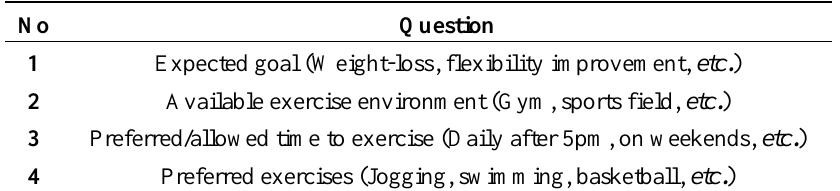
Table 4. Post-test questionnaire.